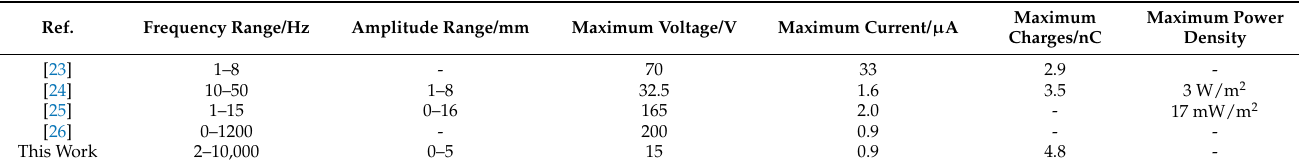
Table 1. The conditions and performance of different TENG-based vibration